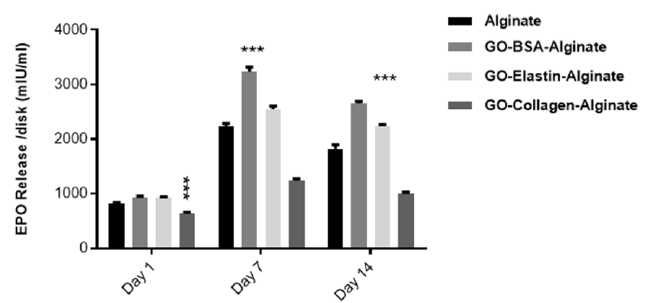
Figure 11. EPO production and release from C 2 C 12 -EPO myoblasts embedded in different hybrid protein-GO-alginate hydrogels. Note:; ***: p < 0.001 compared with cells embedded in alginate without GO.